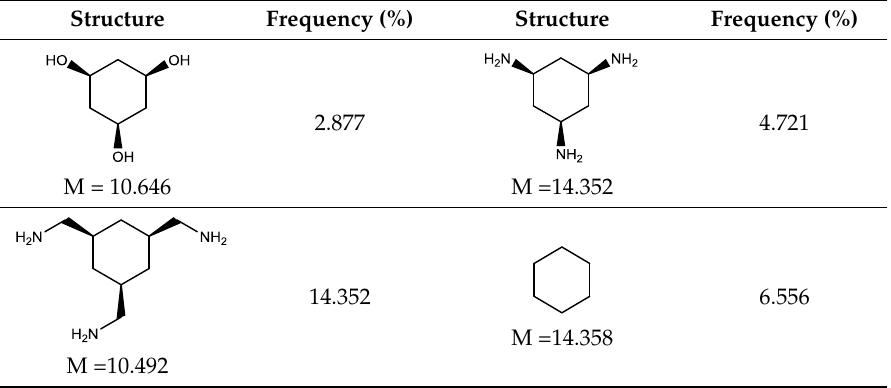
Some RECAP novel molecules suggested for the synthesis using templates arising from RECAP analysis are shown in Table 8. (full output is given in Supplementary Material S3). analysis are shown in Table 8. (full output is given in Supplementary Material S3). Table 8. Molecular fragments identified by RECAP novel molecules for further fusion, molecular Table 8. Molecular fragments identified by RECAP novel molecules for further fusion, molecular Table 8. Molecular fragments identified by RECAP novel molecules for further fusion, molecular Table 8. Molecular fragments identified by RECAP novel molecules for further fusion, molecular Table 8. Molecular fragments identified by RECAP novel molecules for further fusion, molecular Table 8. Molecular fragments identified by RECAP novel molecules for further fusion, molecular mass Table 8. Molecular fragments identified by RECAP novel molecules for further fusion, molecular Table 8. Molecular fragments identified by RECAP novel molecules for further fusion, molecular Table 8. Molecular fragments identified by RECAP novel molecules for further fusion, molecular Table 8. Molecular fragments identified by RECAP novel molecules for further fusion, molecular Table 8. Molecular fragments identified by RECAP novel molecules for further fusion, molecular Table 8. Molecular fragments identified by RECAP novel molecules for further fusion, molecular mass (M) of the compounds are given below their formula. mass (M) of the compounds are given below their formula. Table 8. Molecular fragments identified by RECAP novel molecules for further fusion, molecular mass (M) of the compounds are given below their formula. mass (M) of the compounds are given below their formula. mass (M) of the compounds are given below their formula. (M) of the compounds are given below their formula. mass (M) of the compounds are given below their formula. Table 8. Molecular fragments identified by RECAP novel molecules for further fusion, molecular mass (M) of the compounds are given below their formula. mass (M) of the compounds are given below their formula. mass (M) of the compounds are given below their formula. Table 8. Molecular fragments identified by RECAP novel molecules for further fusion, molecular Table 8. Molecular fragments identified by RECAP novel molecules for further fusion, molecular Table 8. Molecular fragments identified by RECAP novel molecules for further fusion, molecular mass (M) of the compounds are given below their formula. mass (M) of the compounds are given below their formula. mass (M) of the compounds are given below their formula. mass (M) of the compounds are given below their formula. mass (M) of the compounds are given below their formula. mass (M) of the compounds are given below their formula. mass (M) of the compounds are given below their